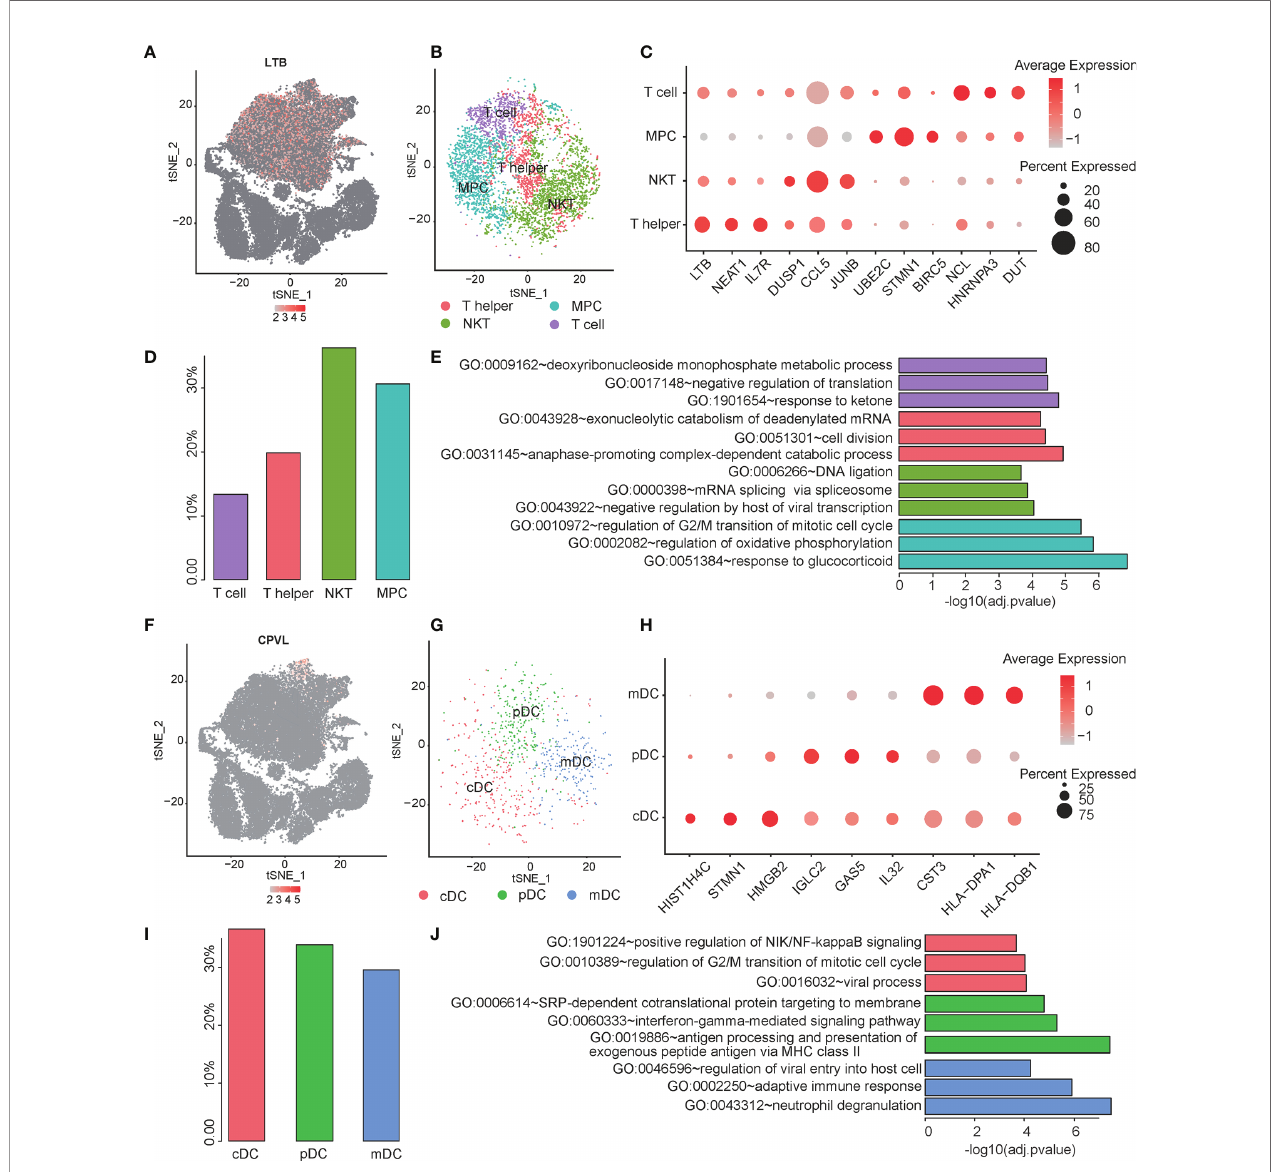
FIGURE 3 | Single-cell analysis of heterogeneity for T cell and Dendritic cell sub-population. (A) The expression distribution of the T cell maker gene – LTB in all cells. (B) The tSNE visualization describes the re-cluster results of T cell subgroups. (C) The bubble chart shows that selected three marker genes are selected for each cell subgroup, and their expression in all cell subpopulations is plotted. (D) The proportion of each subpopulation for T cell. (E) The top three signi fi cant GO categories of marker genes for each subgroup are enriched. (F) The expression distribution of the Dendritic cell maker gene – CPVL in all cells. (G) The tSNE visualization describes the re-cluster results of dendritic cell subgroups. (H) The bubble chart shows that selected three marker genes are selected for each cell subgroup, and their expression in all cell subpopulations is plotted. (I) The proportion of each subpopulation for dendritic cells. (J) The top three signi fi cant GO categories of marker genes for each subgroup are